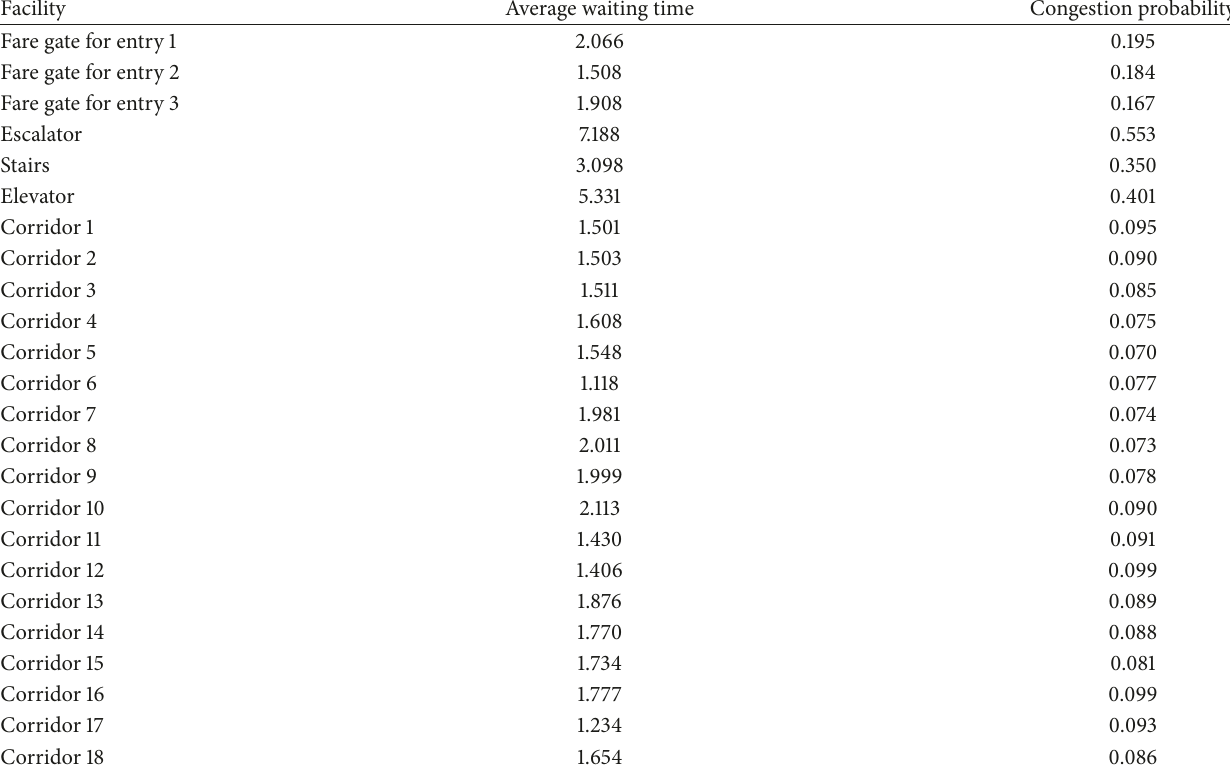
Table 4: Calculation of facilities and